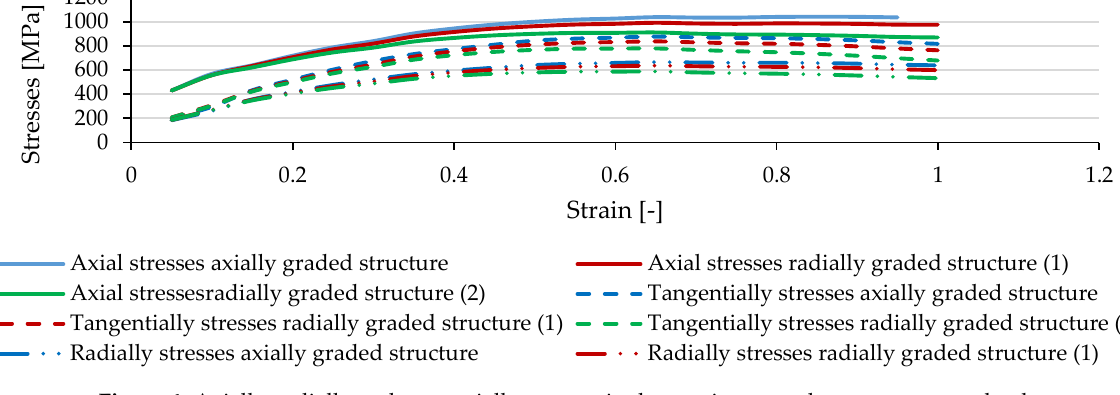
Figure 4. Axially, radially and tangentially stresses in the specimens at the same pressure load.